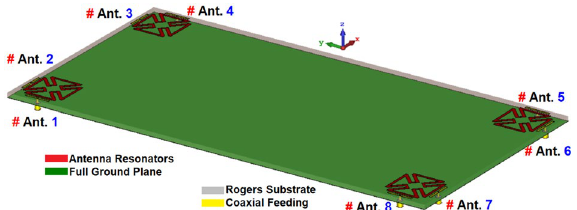
Figure 21. The array with full ground